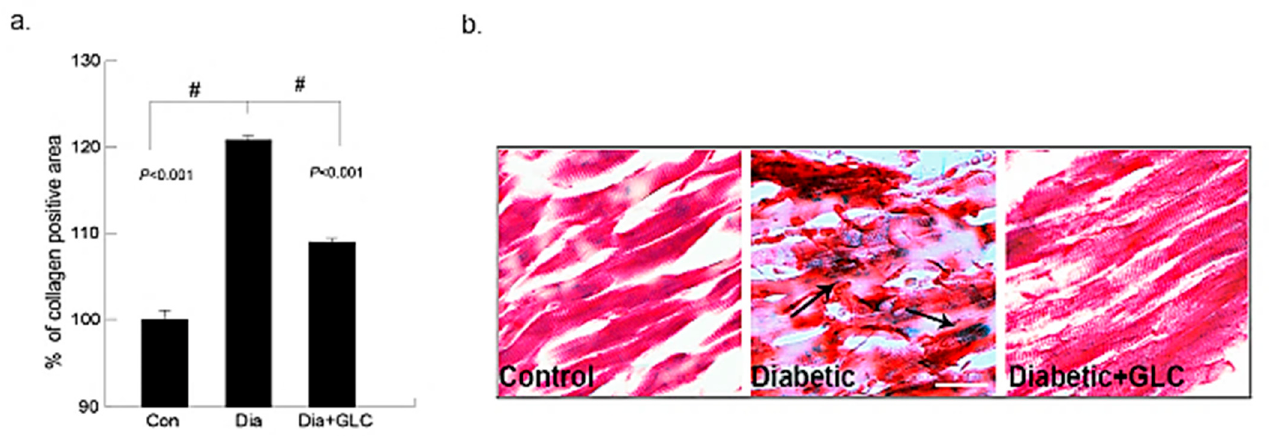
Figure 1. Ventricular heart tissues of type 2 diabetic animals exhibited a significant increase in collagen deposition which was ameliorated after GLC treatment. Changes in collagen deposition in ZDF type 2 diabetic, diabetic with GLC treatment and lean control rats: ( a ) the measurement of collagen positive area; percent of control calculated from the positive trichrome staining (Means ± SE, n = 5); significant level: # p < 0.001; ( b ) histopathological assessment of Gomori’s trichrome stain in control, diabetic and diabetic with GLC groups, arrows indicating collagen deposition and fibrosis. Representative images of Gomori’s trichrome staining of ventricular heart tissues in Con, ZDF diabetic and ZDF diabetic with GLC treated rats (Scale bar = 50 µm).